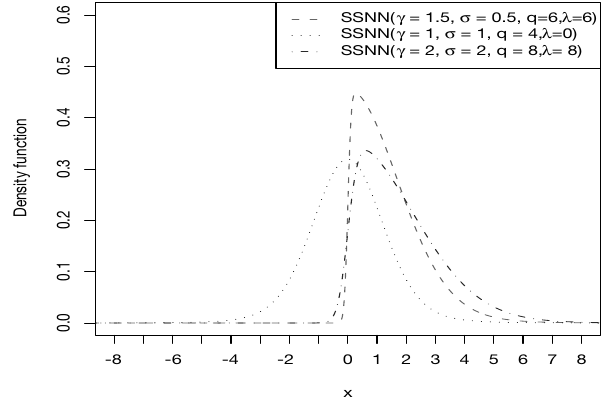
Figure 1 – Skew slash normal-normal density functions for various values of